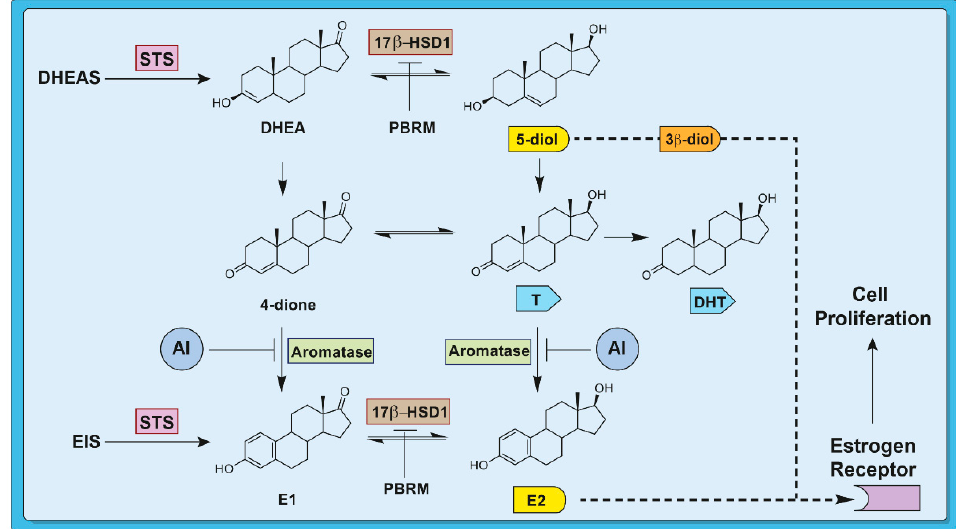
Figure 1. Involvement of three enzymes (STS, 17 β -HSD1 and aromatase) in the formation of estrogens (5-diol and E2) in breast cancer cells and tumors. The formation of 5-diol is not prevented by an aromatase inhibitor (AI), unlike with the use of a 17 β -HSD1 inhibitor such as PBRM.